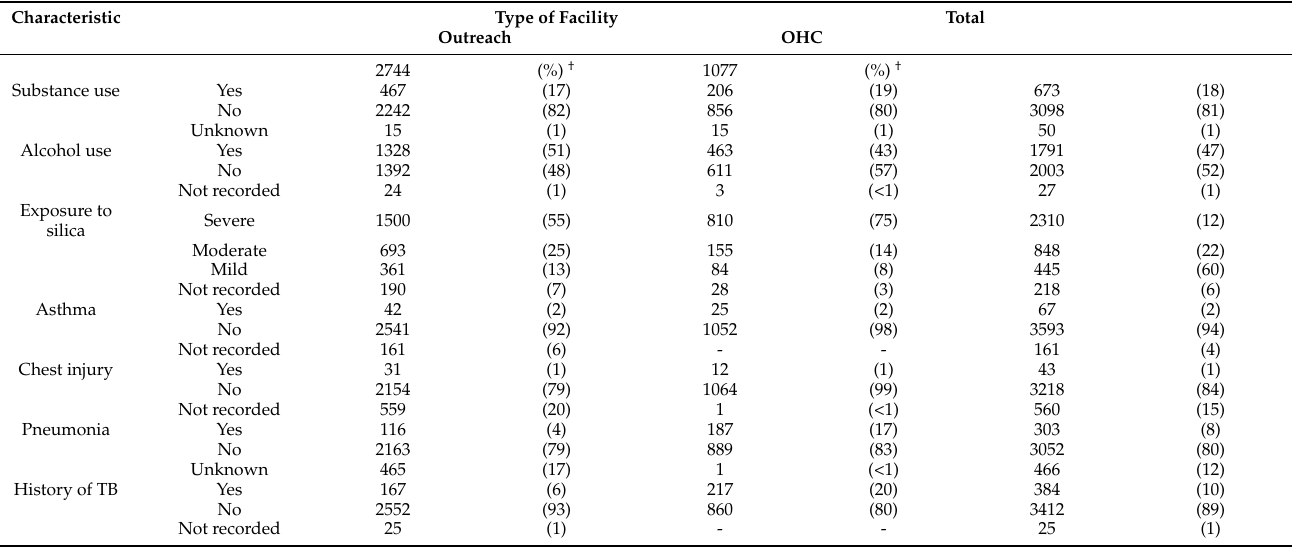
Table 2. Comorbidities among artisanal and small-scale miners in